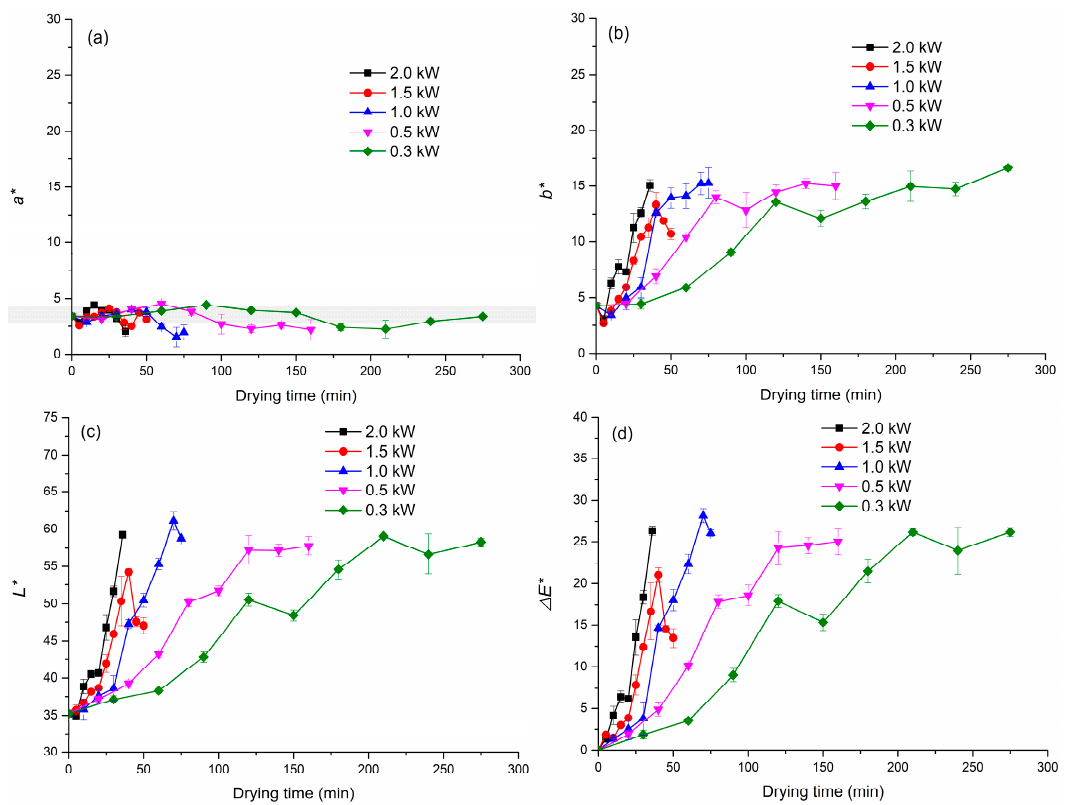
Figure 3. Kinetics of the color parameter changes of coffee beans during MVD: ( a ) a*; ( b ) b*; ( c ) L*; and ( d ) Δ E .